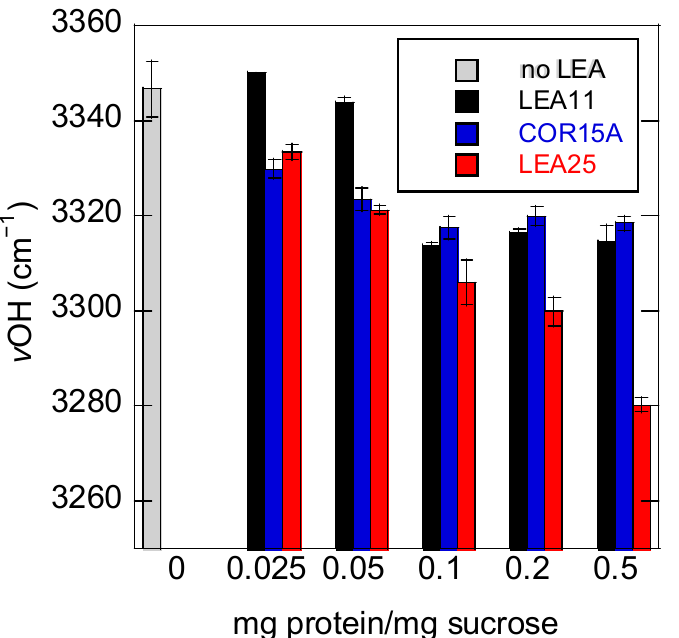
Figure 7. Dependence of the ν OH peak position of dry Suc glass on the ratio mg protein/mg Suc. Before dehydration, samples contained 10 mg/mL Suc in H 2 O and, in addition, the respective amount of protein to reach the indicated ratios, mg protein/mg Suc. Samples were dried on CaF 2 windows, and spectra were recorded at 30 °C. Values are means from at least three samples ± standard deviation. 3260